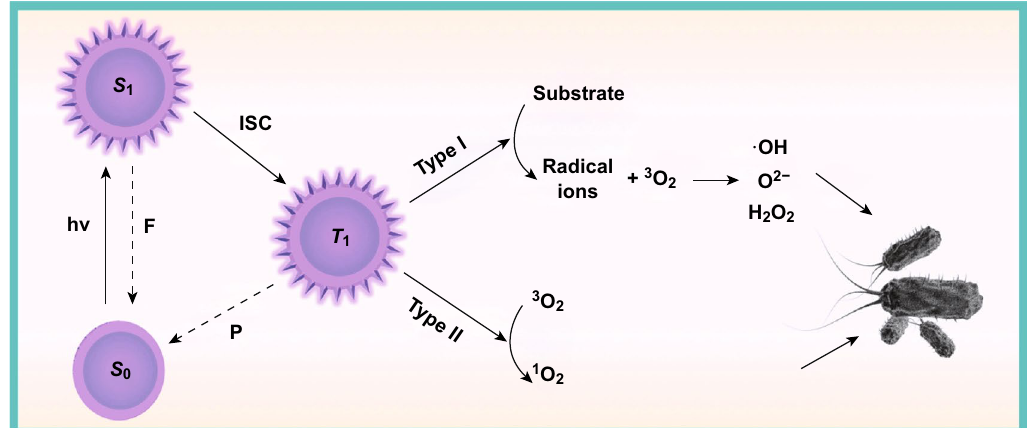
Fig. 2 Photochemical processes involved in photodynamic inactivation of